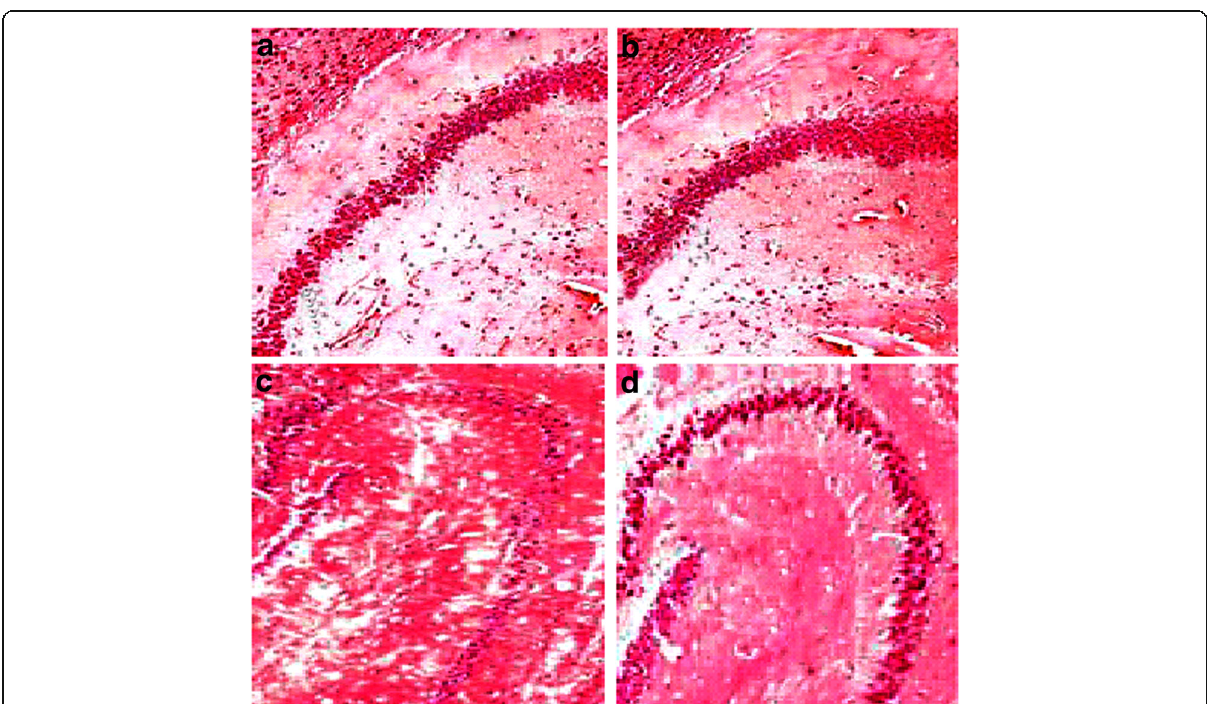
Fig. 15 Effect of EGCG on the Fl-induced changes in the histology of neurons in the hippocampus of control and Fl exposure ( a – d ). a Control rats: normal hippocampal tissue histology is seen (× 40). b EGCG rats: although similar hippocampal tissue histology was observed compared to control (× 40). c Fl-treated rats: increased degenerative changes, shrinkage cytoplasm, and extensively dark picnotic nuclei in neurons of the hippocampus are seen (× 40). d Fl-treated rats with EGCG: effective preventing of degenerative changes and shrunken in cytoplasm and nuclei are prominent in neuronal cells. (H&E ×